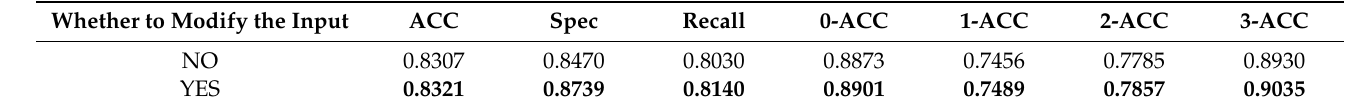
Table 2. Validation set results for comparison tests using modified input